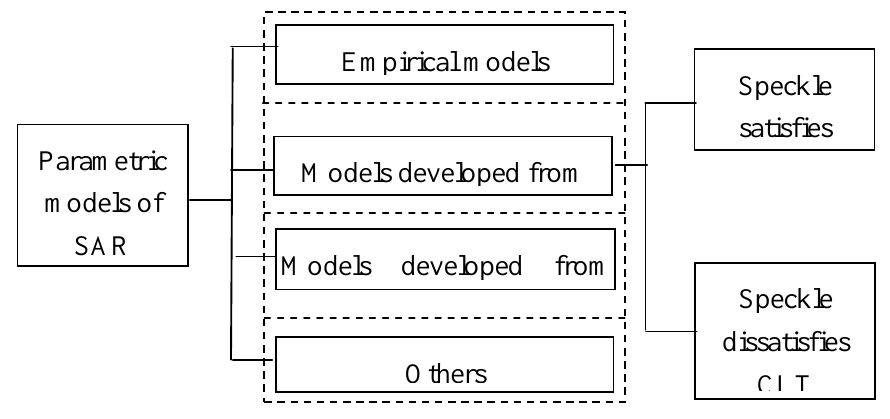
Figure 2. Four major categories of parametric modeling Note: PM represents the product model; CLT represents the central limit theorem; GCLT represents the general central limit